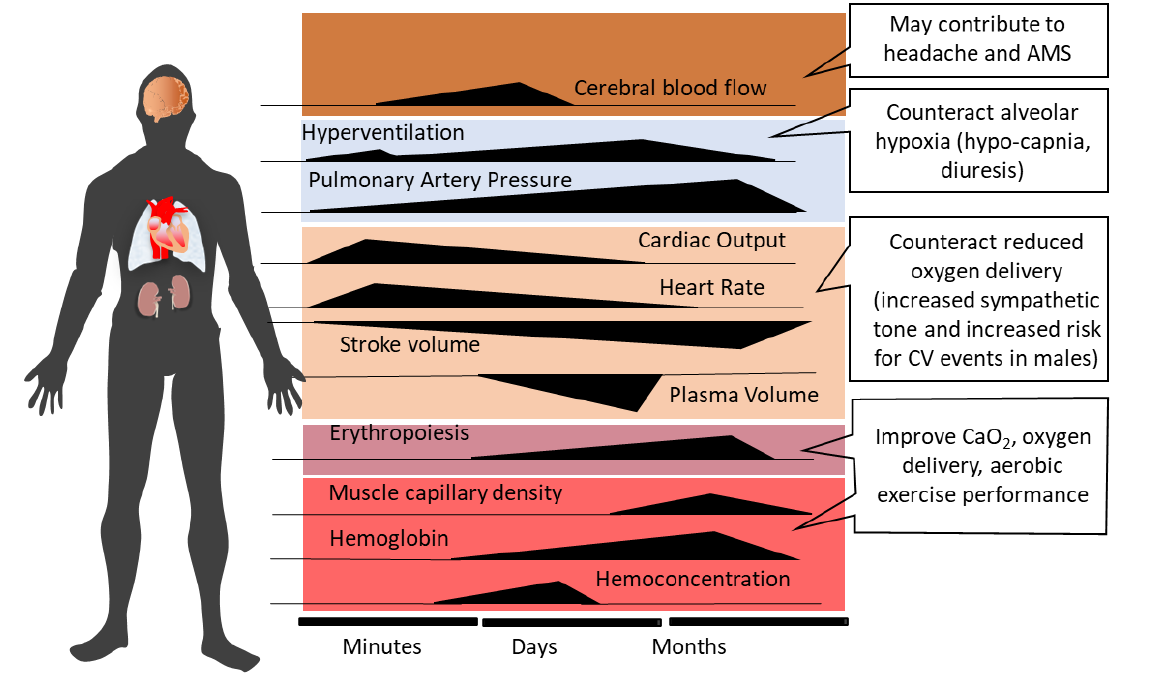
Figure 1. Time-dependent changes and related consequences of physiological responses during acclimatization to high altitude (modified from Burtscher et al., 2022 [10] ). AMS, acute mountain sickness; CV, cardiovascular; CaO 2 , arterial oxygen content.